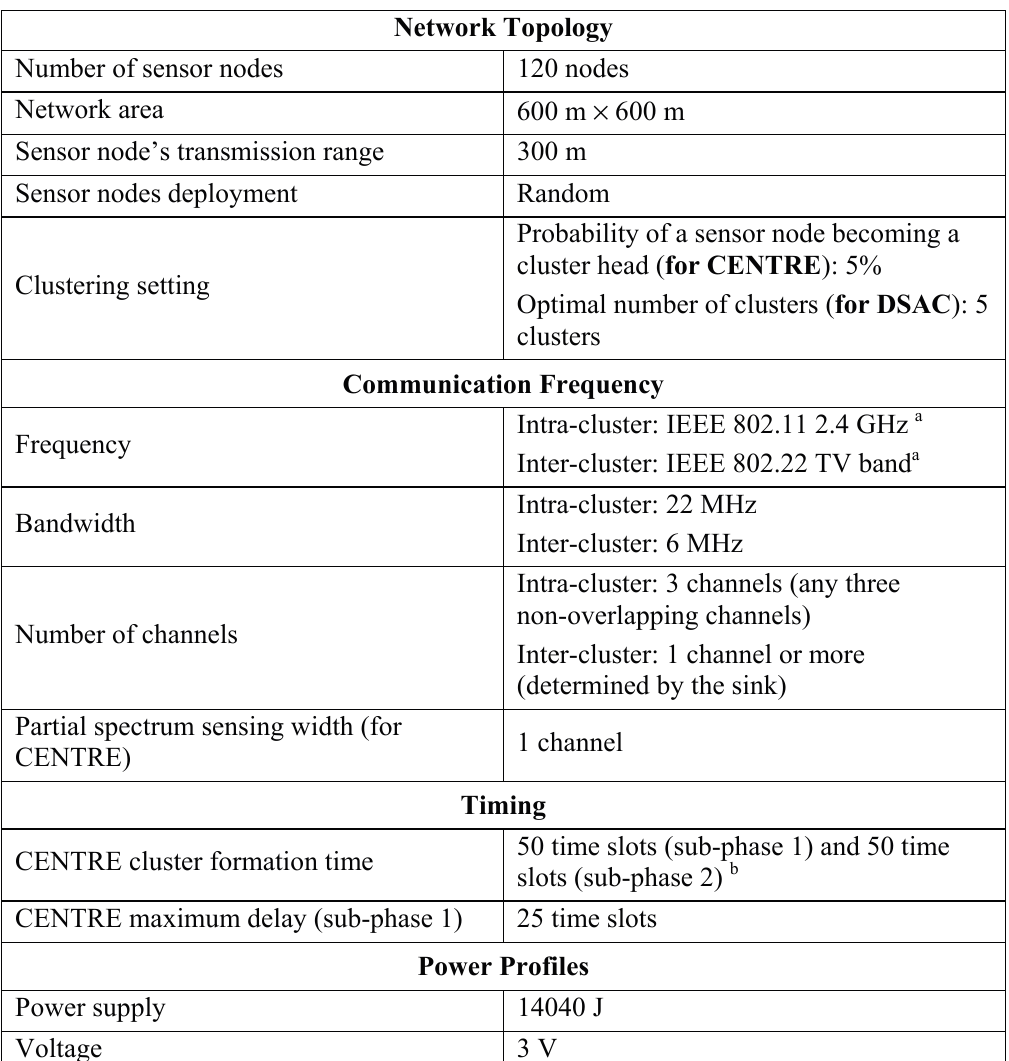
Table 1. Simulation